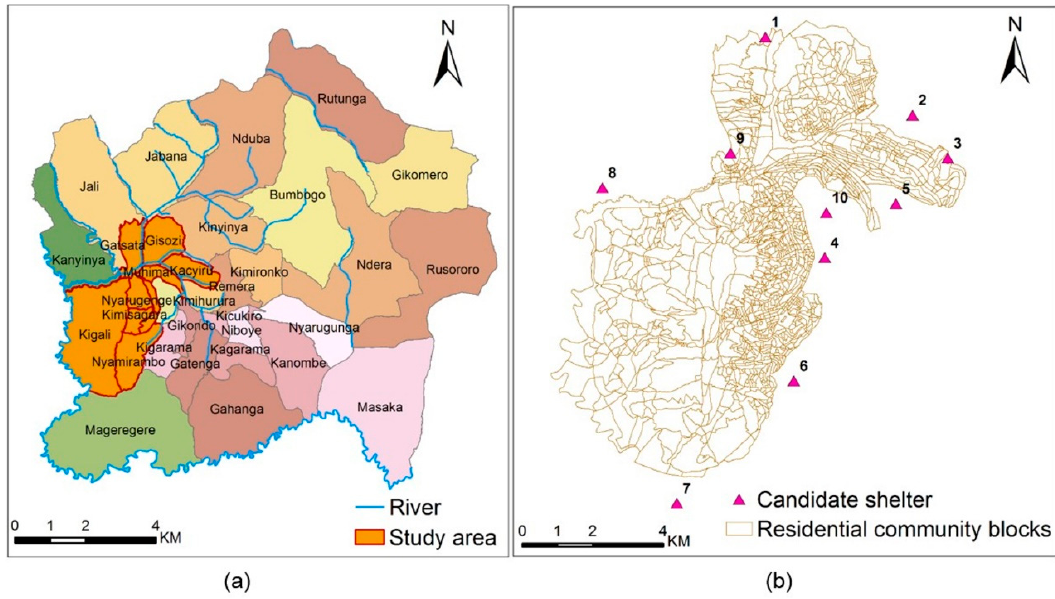
Figure 6. Maps of ( a ) the geographical location of the selected sectors of the city of Kigali, and ( b ) the candidate shelters and residential blocks of the selected study area.